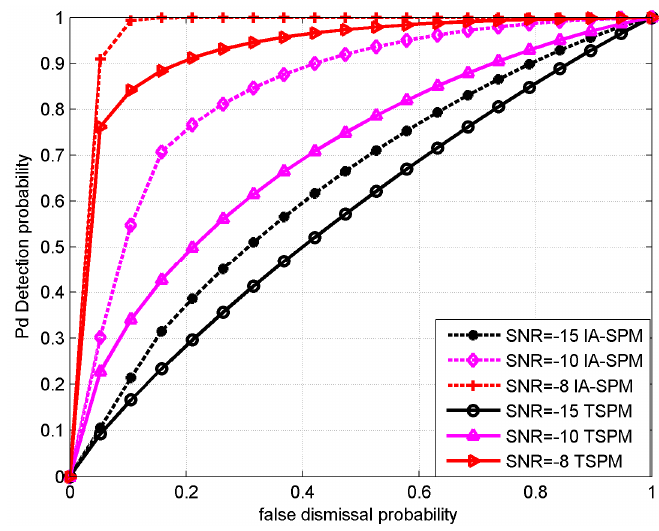
Figure 8. Comparison of the IA-SPM vs. the TSPM at different SNR values.